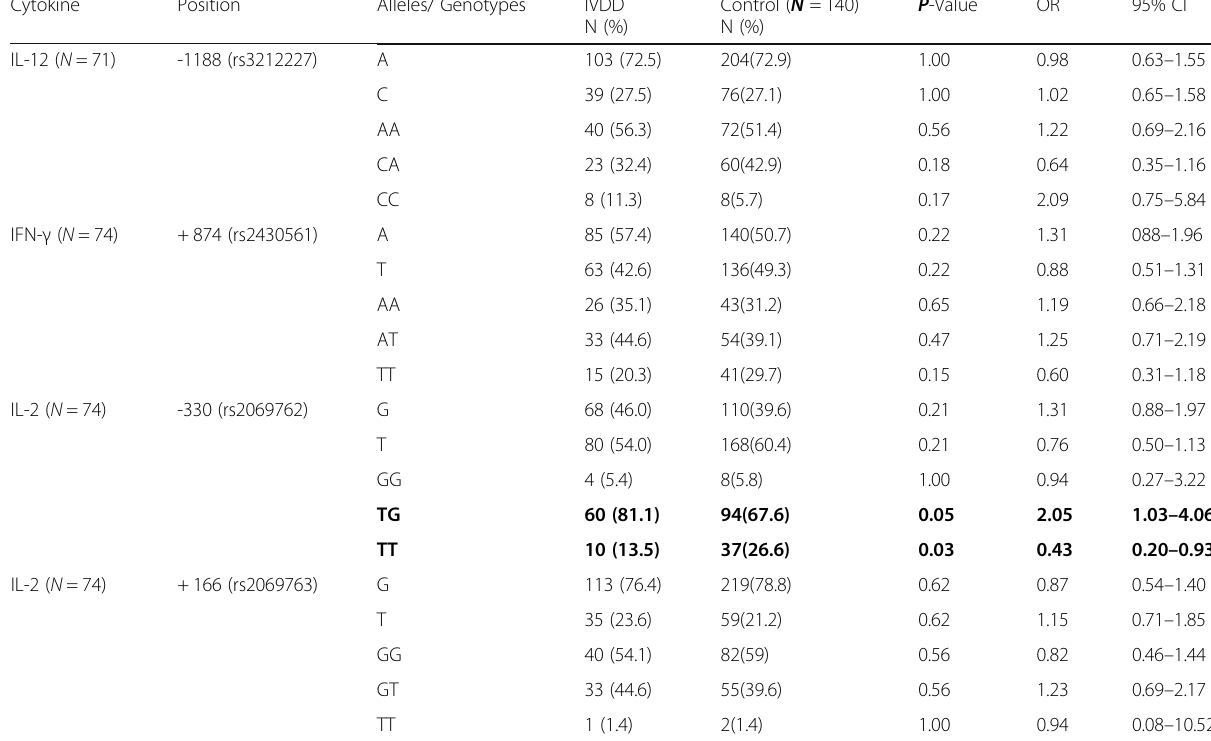
Control ( N = 140) N (%) N (%)